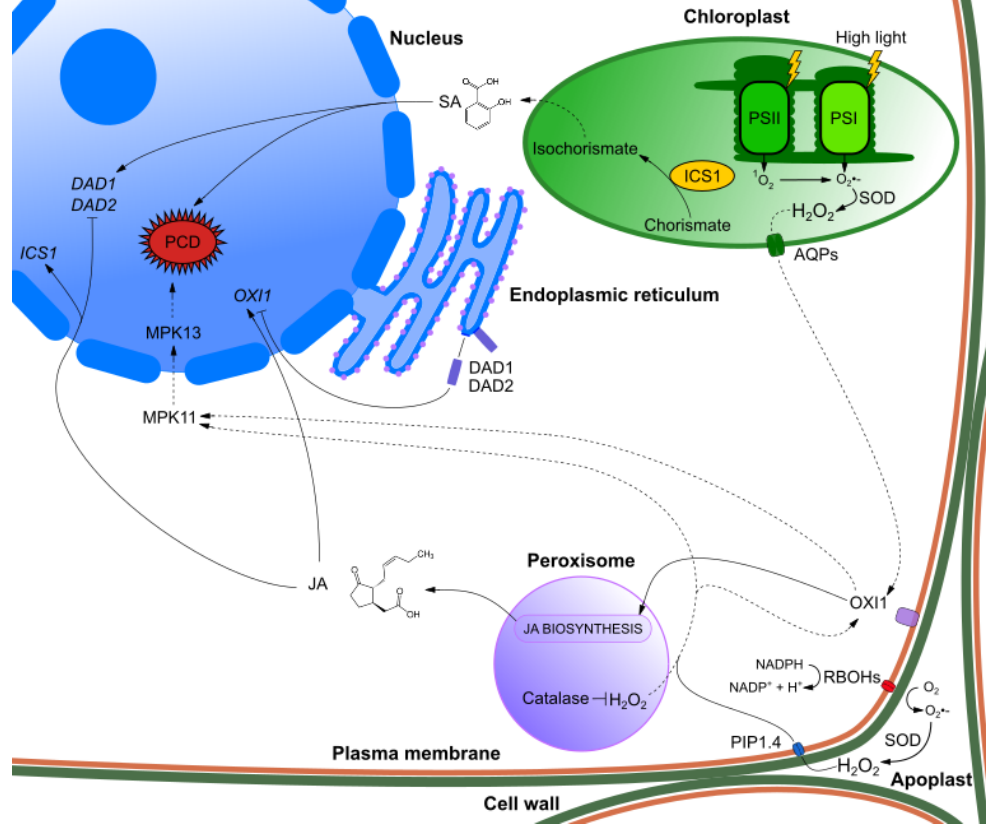
Figure 1. Role of oxidative signal inducible 1 (OXI1) in retrograde signaling in mature mesophyll cells. OXI1 in response to reactive oxygen species (ROS) induces biosynthesis of jasmonic acid (JA) and induces programmed cell death (PCD) through MPK11 / MPK13-mediated pathway. JA induces expression of ICS1 . Crosstalk between SA and JA along with endoplasmic reticulum (ER)-associated proteins DEFENDER AGAINST CELL DEATH (DAD1) / DAD2 regulates expression of OXI1 . Dotted lines represent pathways which lack experimental evidence or exact nature of indicated regulation is still unknown.